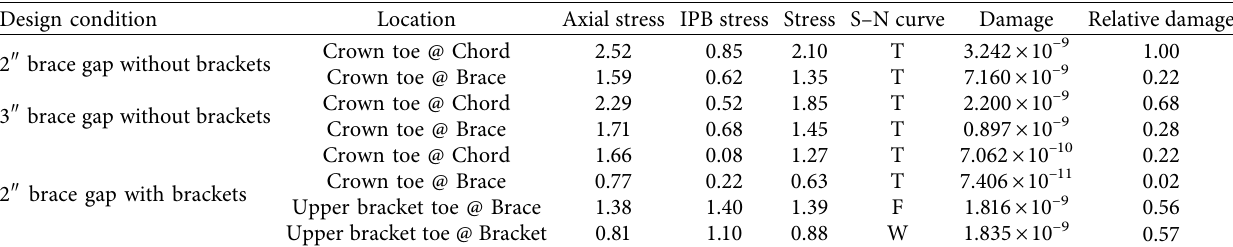
Figure 8: Details of stress level at the upper bracket-to-brace connection under: (a) axial loading and (b) IPB loading. Table 6: Comparison of fatigue damage for the KT-joints under different design conditions. Design condition